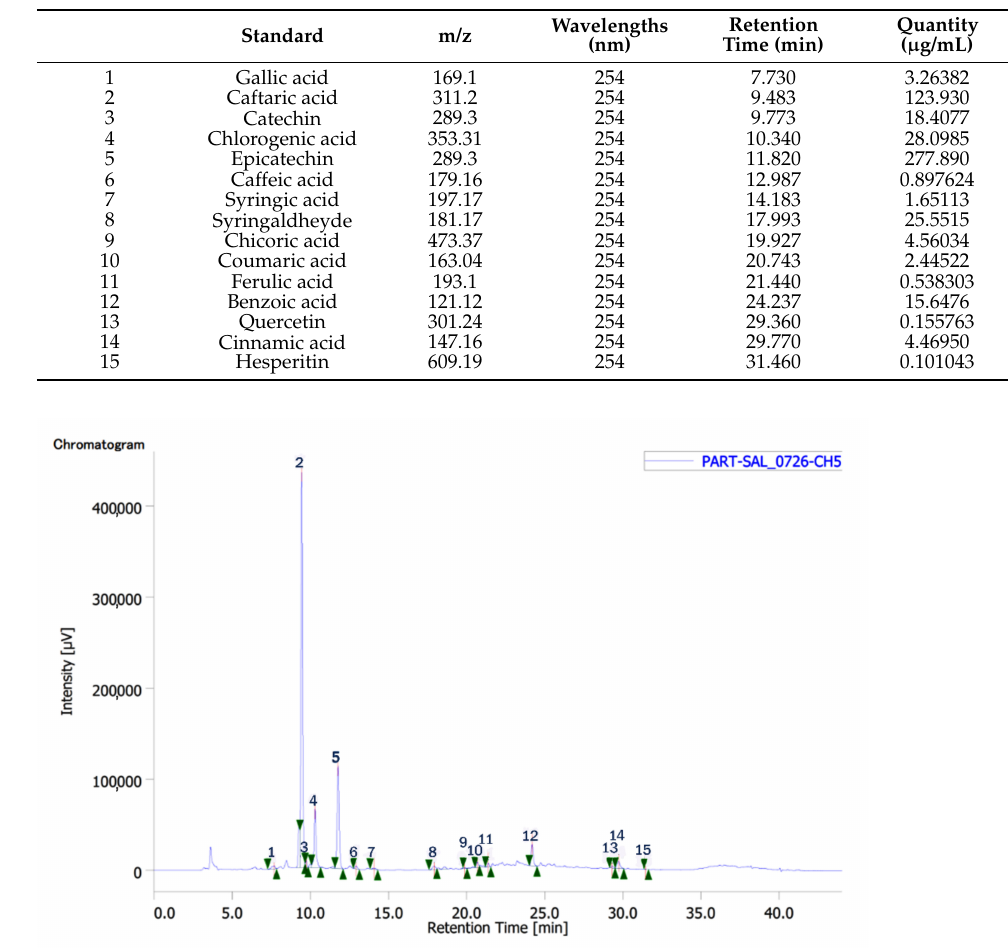
Figure 3. Chromatographic analysis of phenolic compounds, in the formula (20 mg/mL). Caftaric acid (peak #2; Rt: 9.483 min; Conc.: 123.93 µ g/mL) and epicatechin (peak #5; Rt: 11.820 min; Conc.: 277.89 µ g/mL) were the prominent